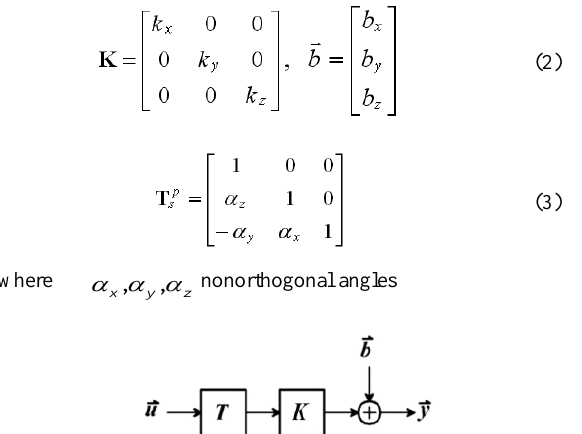
Figure 2. Sensor error model of specified sensor